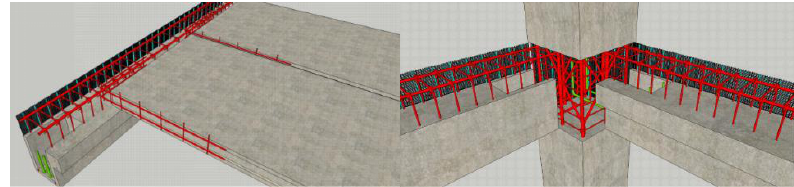
Figure 5. Schematic diagram of the lap joints of prefabricated members.